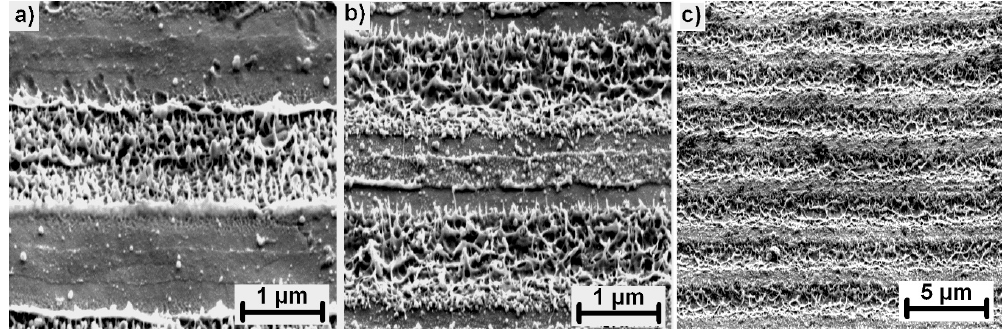
Figure 7. High magnification images of a tungsten surface irradiated with 1 mJ (0.81 J/cm 2 ) and a single pulse ( a ), 5 pulses ( b ), and 10 pulses ( c ). All images are captured with the sample tilted 55°.